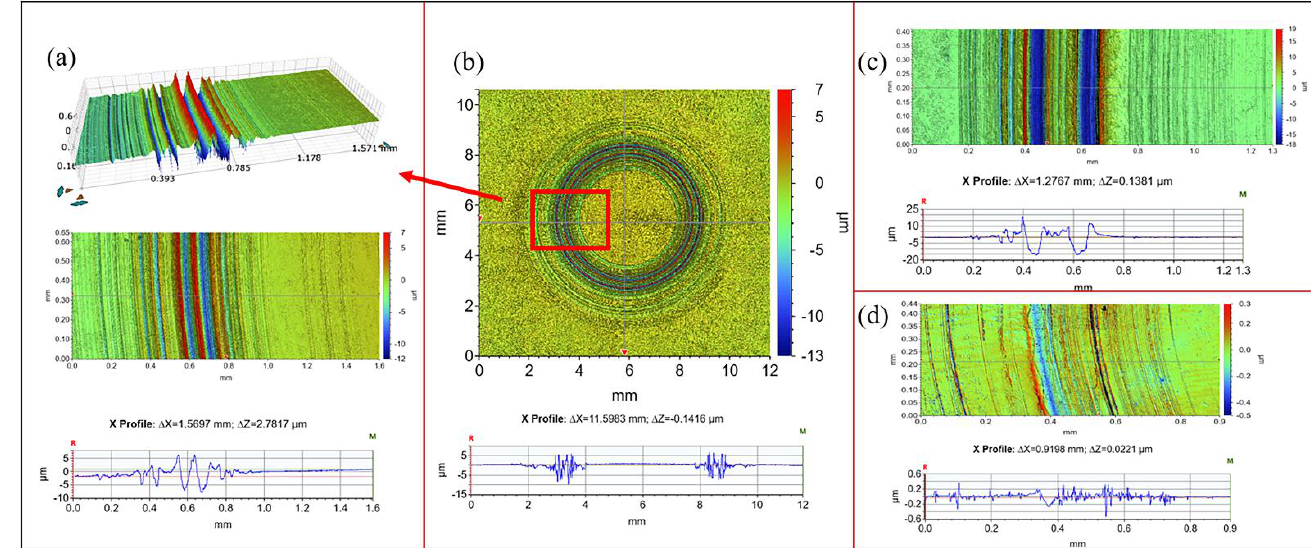
Figure 9. Wear topography diagrams. ( a ) Wear topography diagram of part of the coated and textured sample; ( b ) wear topography diagram of the whole coated and textured sample; ( c ) wear topography diagram of the coated sample; ( d ) wear topography diagram of the textured sample.